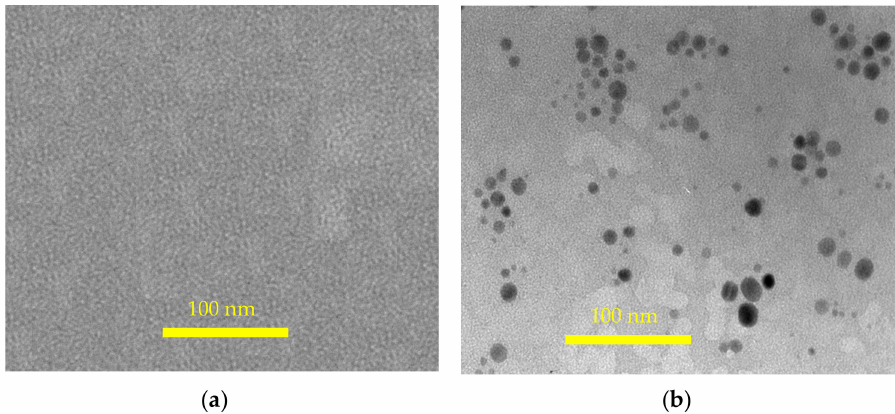
Figure 8. TEM images of pristine natural rubber ( a ) and 3 phr silica filled natural rubber ( b ). The thermal degradation of both the pristine NR and the 3 phr nanosilica filled NR composites was examined in terms of the weight loss (%) as a function of temperature, as shown in Figure 9.